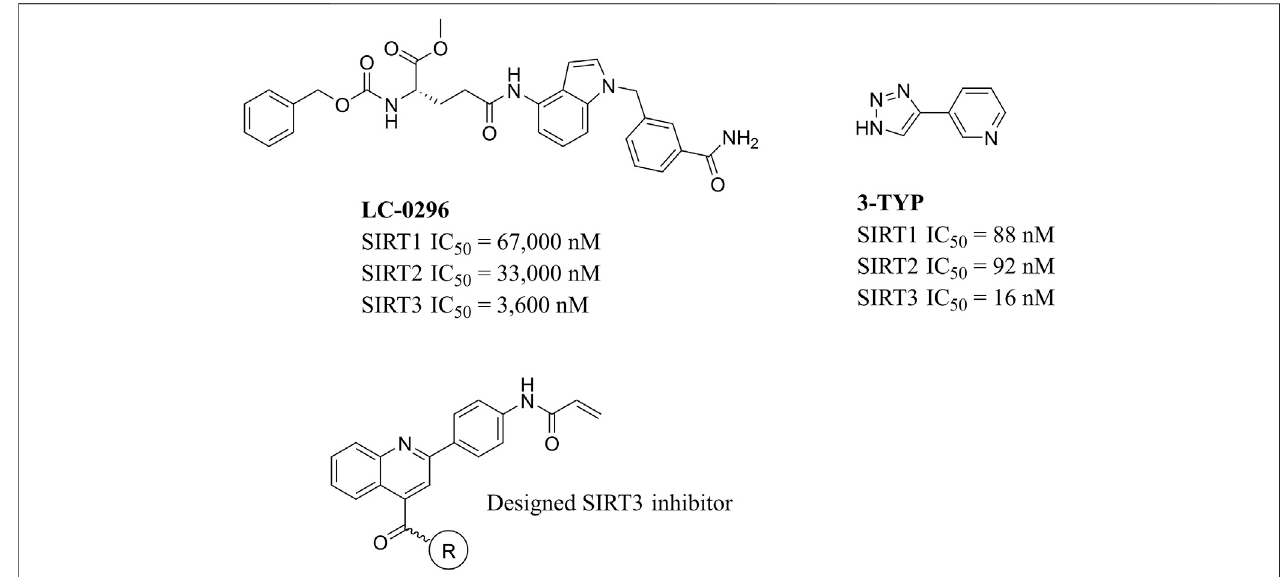
FIGURE 1 | Structure of LC-0296, 3-TYP and the designed SIRT3 inhibitors in the current